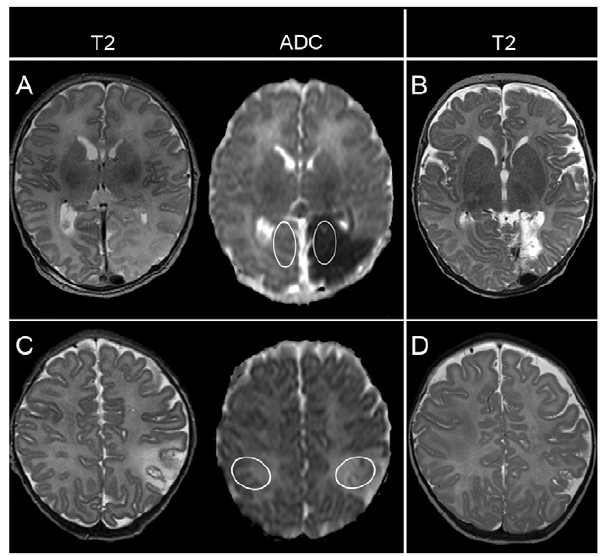
Figure 1. Examples of ADC measurements in the neonatal ADC map. This infant was scanned on day 4 and suffered a posterior cerebral artery stroke (A). The ROI is placed in the region that corresponds with the cystic evolution at three months (B) and a corresponding ROI is placed in the contralesional hemisphere. The same is shown for an infant with a cortical MCA stroke who was scanned on day 10 (C), but shows focal atrophy at three months. (D).